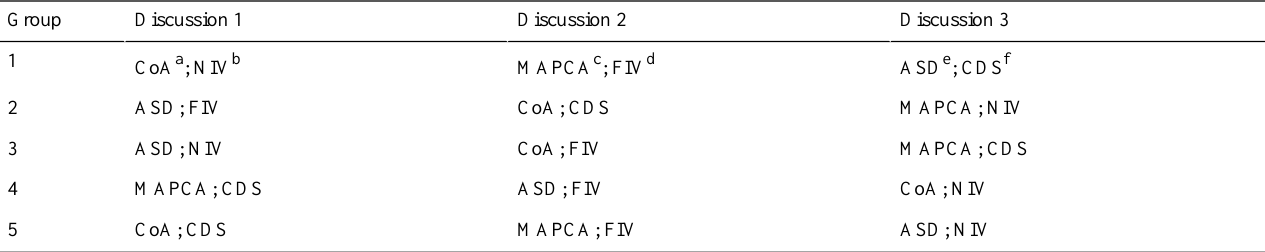
Table 2. Discussion orders (congenital heart disease variation; display system) of each